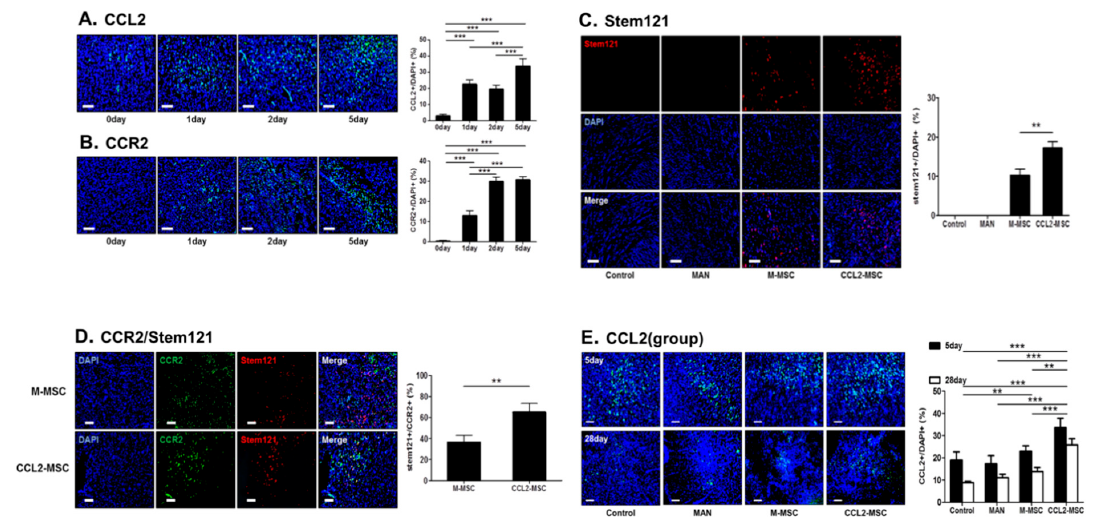
Figure 4. Changes in CCL2 and CCR2 levels in the brain during the acute stroke phase and correlations between MSC migration and CCR2 levels following transplantation. ( A , B ) Representative immunostaining images showing changes in CCL2 and CCR2 levels on days 1, 2 and 5 after MCAo induction as compared before induction. The graph shows the number of CCL2+ or CCR2+ cells in each group. Data were analyzed by one-way ANOVA test. ( C ) The CCL2-MSC group showed enhanced engraftment into the peri-infarct area relative to the M-MSC group. The graph shows the number of Stem121+ cells in the peri-infarct area in each group. Data were analyzed using a paired Student’s t test. ( D ) Co-immunostaining images of CCR2+ and Stem121+ cells in the peri-infarct area in each group on 5 day after MCAo induction. The graph shows the number of Stem121+/CCR2+ cells in each group. Data were analyzed using a paired Student’s t test. ( E ) Representative immunostaining images showing changes in CCL2 levels at 5 and 28 days after MCAo induction between treatment groups. The graphs show the number of CCL2+ cells in each group. Data represent the mean ± SEM and were analyzed by one-way ANOVA. ** p < 0.01, *** p < 0.001. Scale bar = 100 µm.